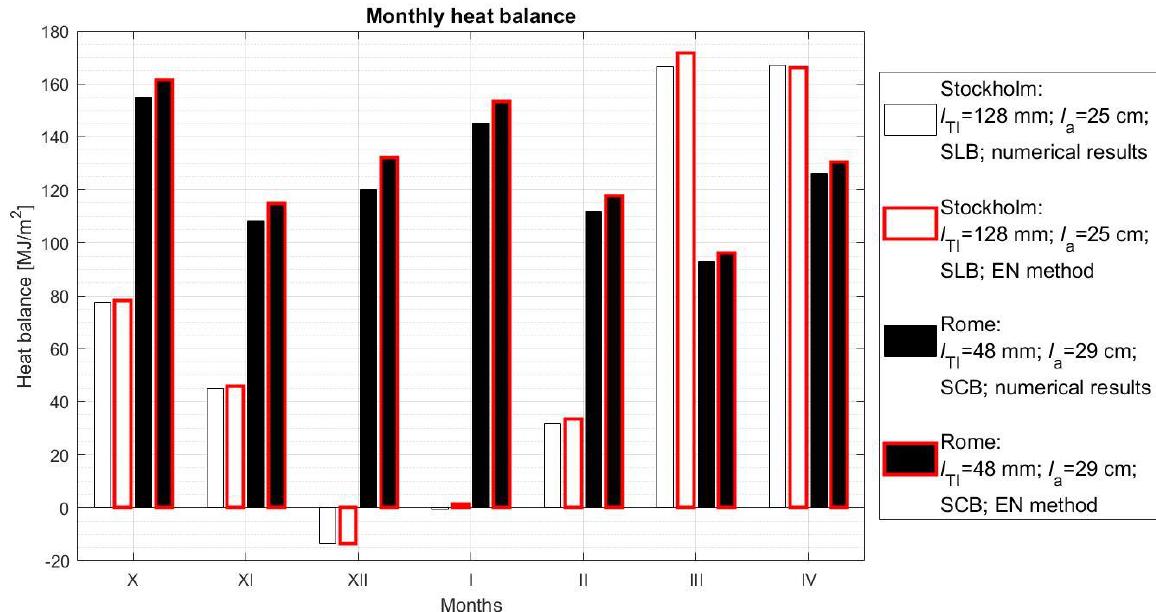
Figure 14. Monthly minimum, mean, and maximum temperature of the SWs’ internal surface in the case of TI thickness and AL parameters and materials proposed for the considered locations.